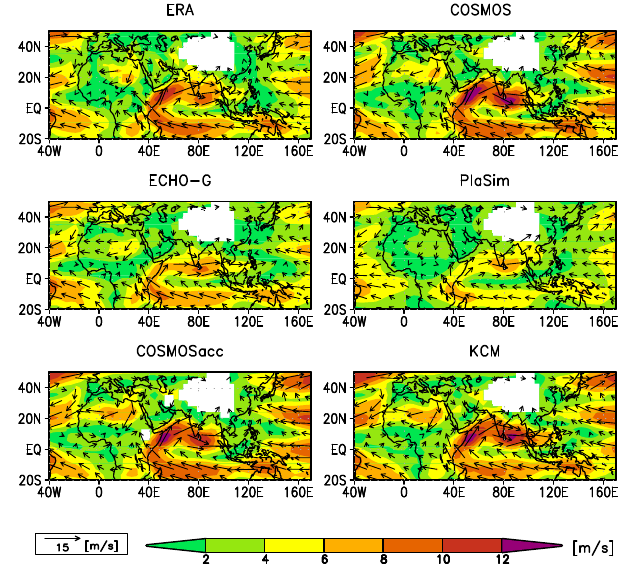
Figure A1. Simulated pre-industrial (0k) atmospheric circulation in 850hPa (vector, ms − 1 ) and wind intensity (shaded, ms − 1 ) during the summer season (MJJASO). Compared to the ERA40 reanalysis data (ERA, 1979–1999, Uppala et al., 2005). No wind vectors are shown were the model orography exceeds the